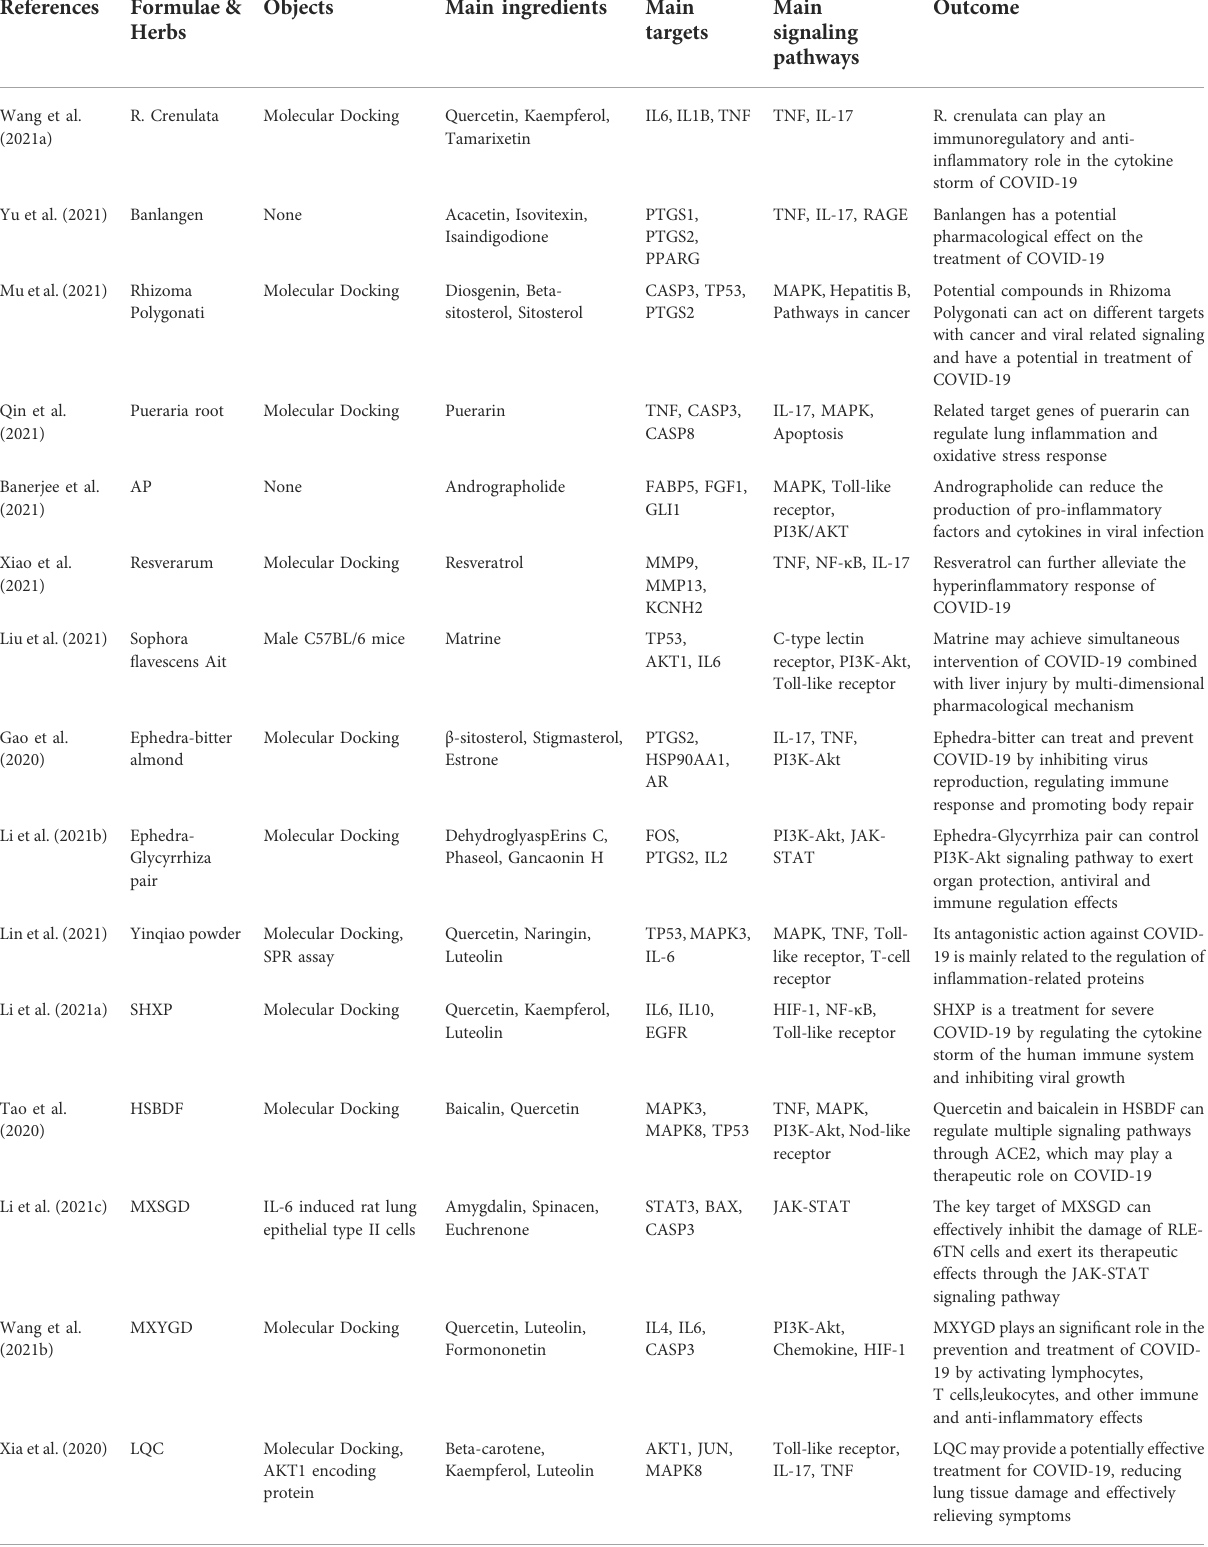
TABLE 1 Network pharmacology analysis of TCM in the treatment of